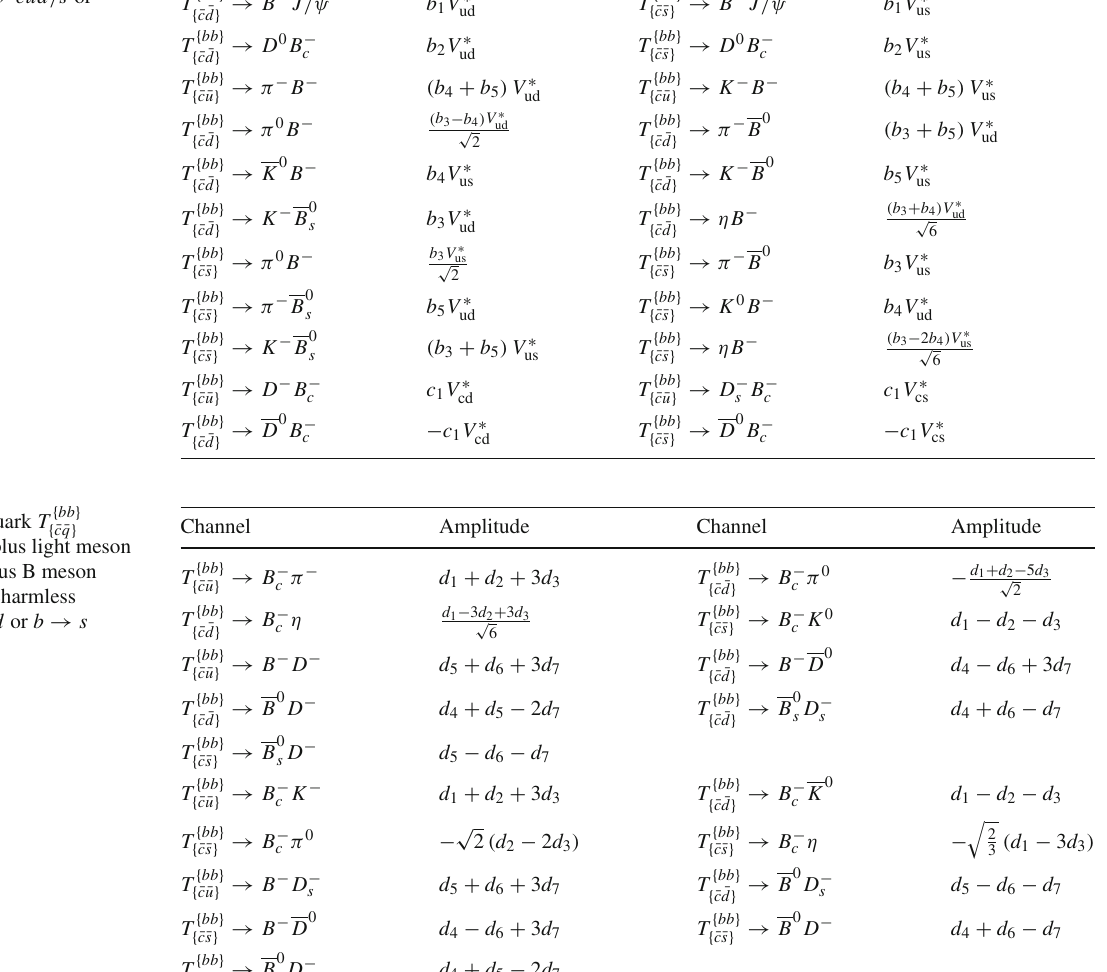
Table 4 Tetraquark T decays into two mesons with the transition of b → c ¯ ud / s or b → u ¯ cd / s